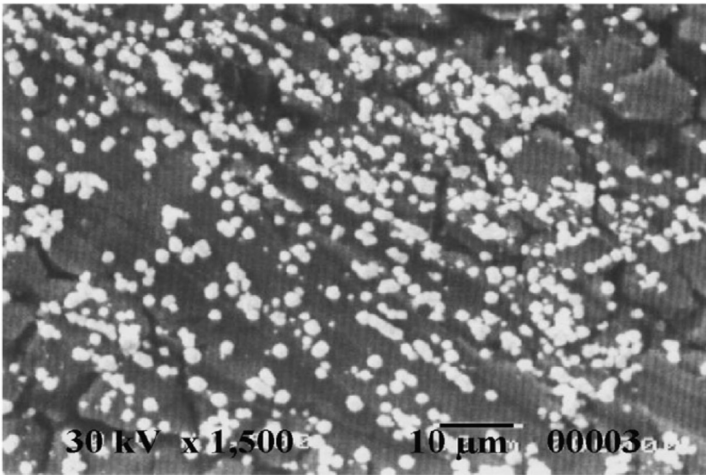
Figure 4. Micrographs of mild steel after immersion in 2 M HCl solution in the presence of 400 ppm of the inhibitor [72].